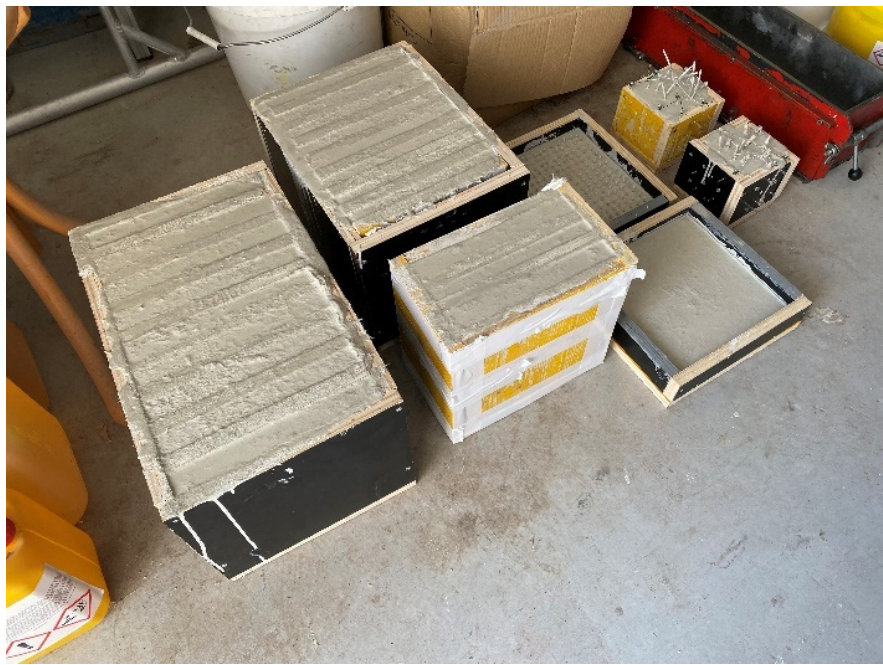
Figure 19. Formwork and hardening process of unified slab samples.